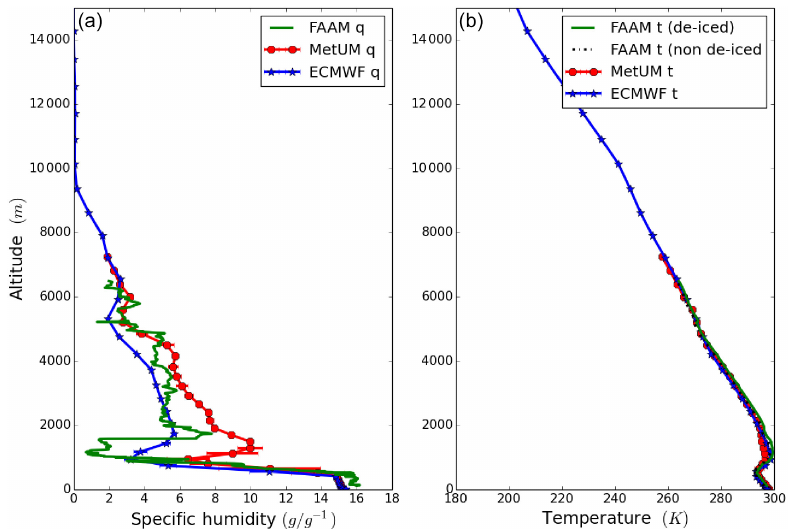
Figure 8. Case study 1, B920, 7 August, P7. (a) Water vapour mixing ratio from the aircraft measurements in the profile (green) compared with the MetUM (red) and ECMWF–CAMS (blue). (b) The same but for temperature – here there are two measurements of temperature shown, which are in good